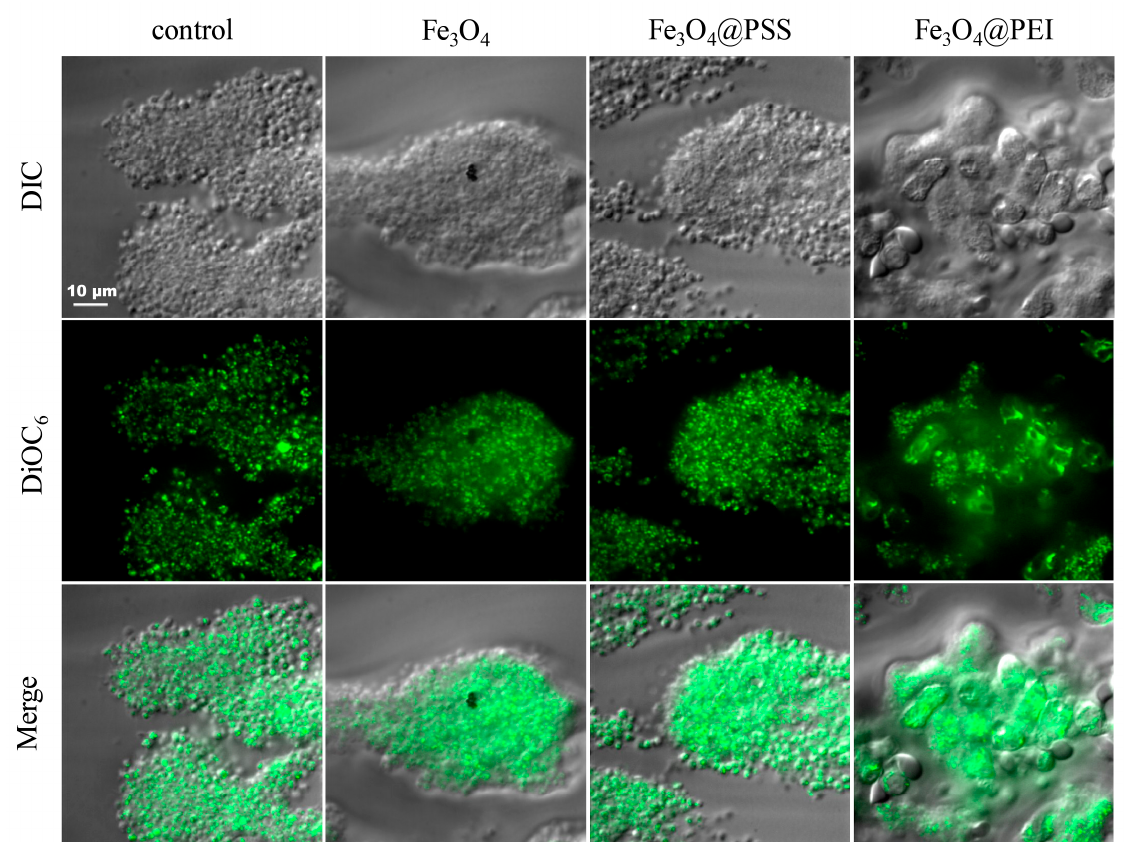
Figure 9. Micrographs of blood clots in the chamber in various shooting modes. DIC = differential interference contrast (optical microscope); DiOC 6 = cell-permeant lipophilic dye that is selective for the mitochondria of live cells (fluorescence microscopy); Merge = summarized image (optical and fluorescent